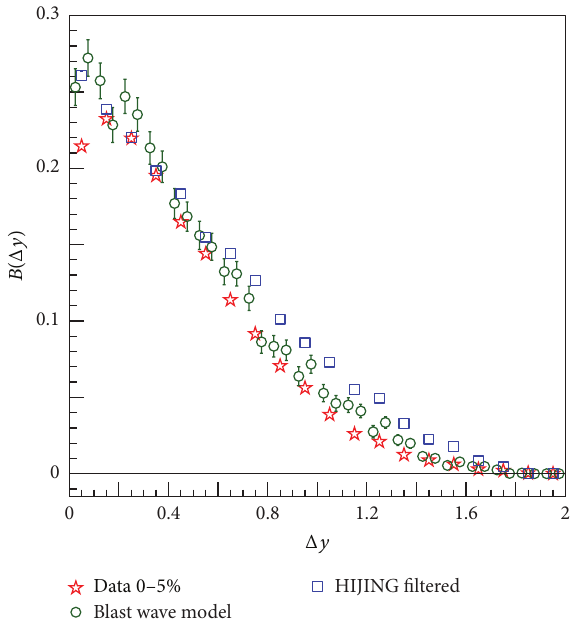
Figure 21: The balance functions in terms of Δ𝑦 for identified charged pion pairs from Au+Au collisions at √𝑠 nine centrality bins. The graph is taken from [28].